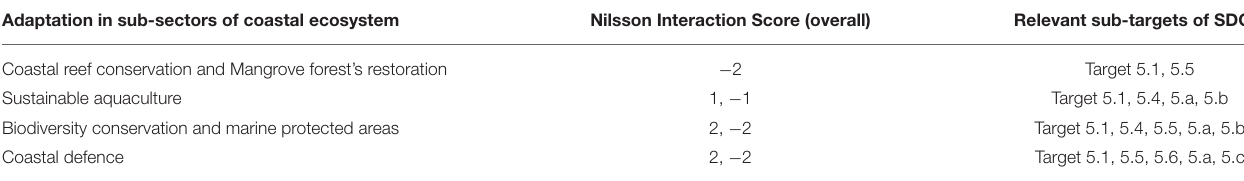
TABLE 1 | Assessment of interactions between coastal climate adaptation and gender using the Nilsson Interaction Score. Adaptation in sub-sectors of coastal